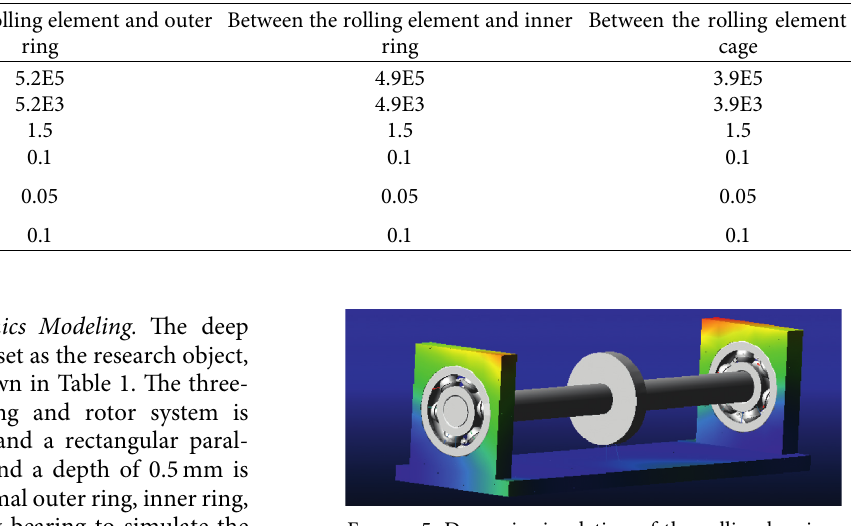
Figure 4: The rotor system model of the rolling bearing test bed. Table 2: Simulation contact parameter setting.